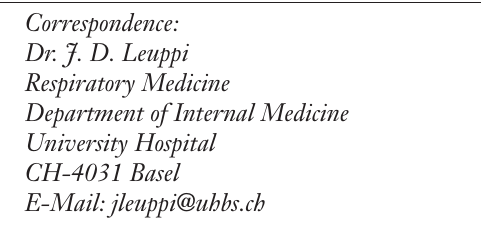
Values for individual data and geometric mean (95% CI) showing an increase in the dose of mannitol to provoke a 15% fall in FEV 1 (PD 15 ) following 6–9 weeks treatment with budesonide compared to before treatment in 18 asthmatic subjects. Following budesonide treatment, seven of the 18 subjects no longer responded to mannitol and have simply been assigned a PD 15 of 635 mg designated by the open cir- cle. Eleven subjects still recorded a 15% fall in FEV 1 and thus remained positive to mannitol following budesonide. How- ever, the dose of mannitol required to cause the same 15% fall in FEV 1 was significantly greater. Taken from Brannan et al.